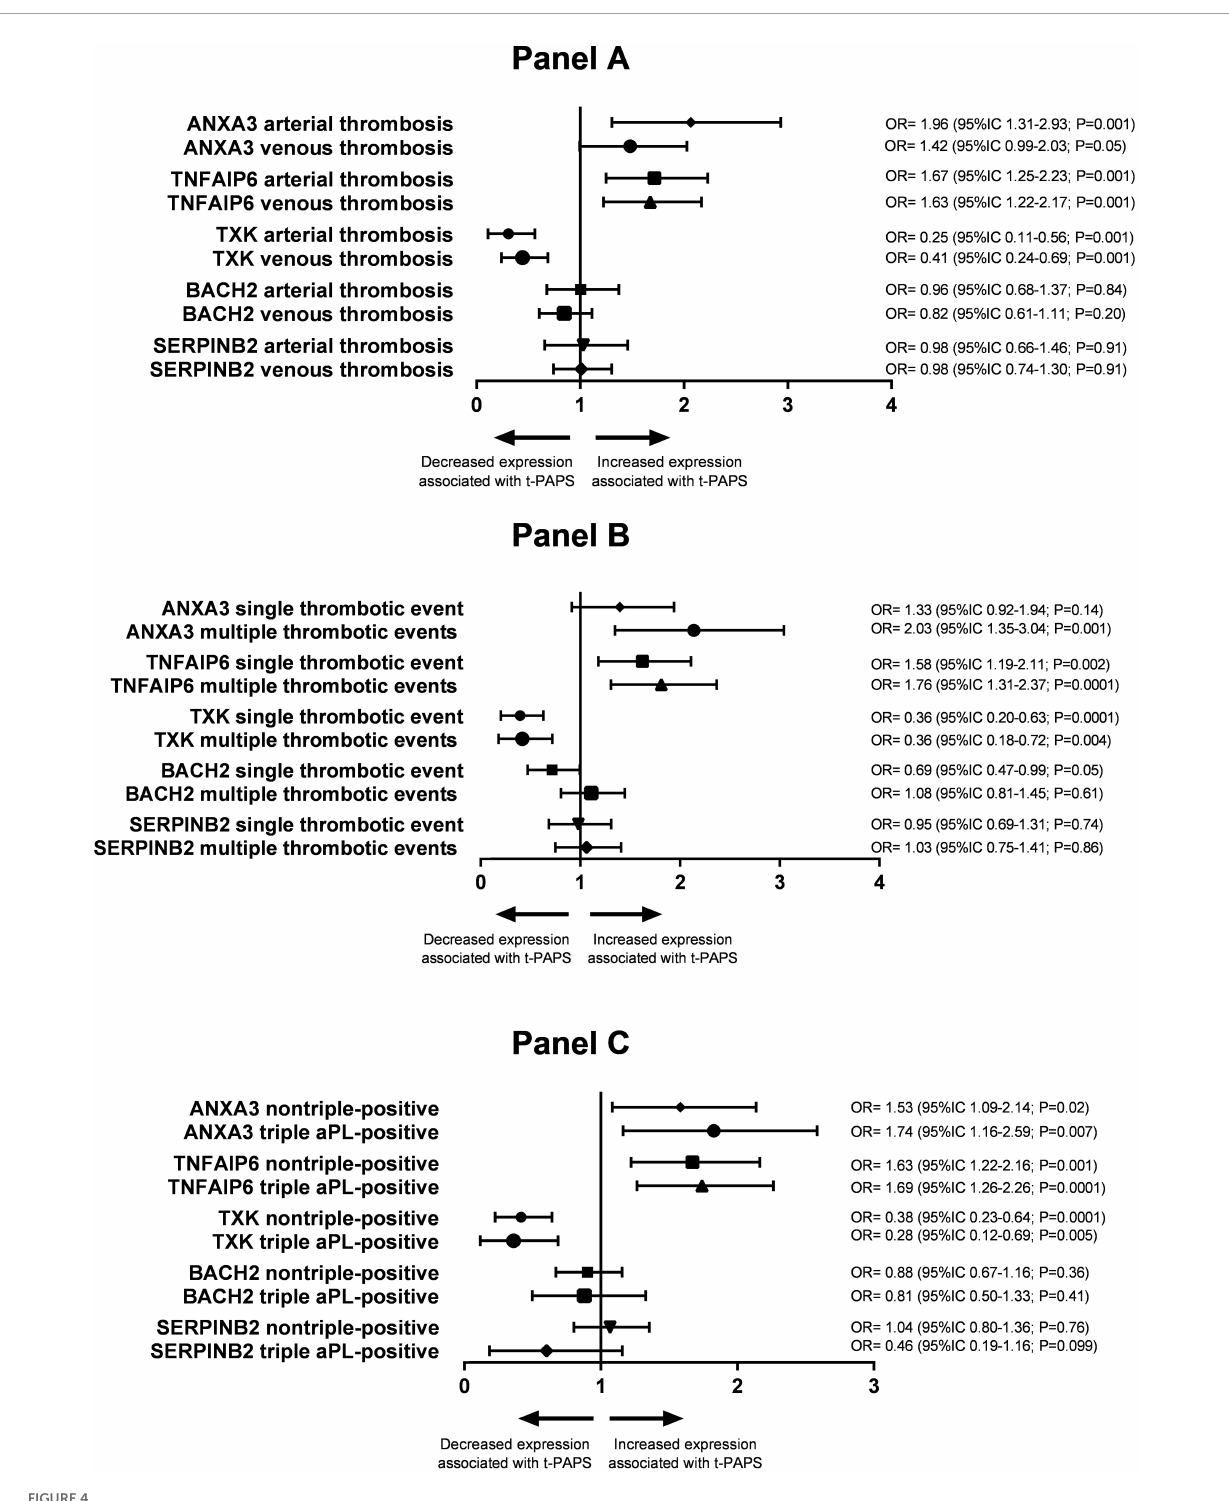
FIGURE4 Panel (A) association between the relative expression of the study genes and arterial or venous thrombosis in t-PAPS. Panel (B) association between the relative expression of the study genes and a single thrombotic event or multiple events in t-PAPS. Panel (C) association between the relative expression of the study genes and non-triple-positive or triple aPL-positive subgroups. OR, odds ratio; CI, confidence interval; t-PAPS, primary thrombotic APS.